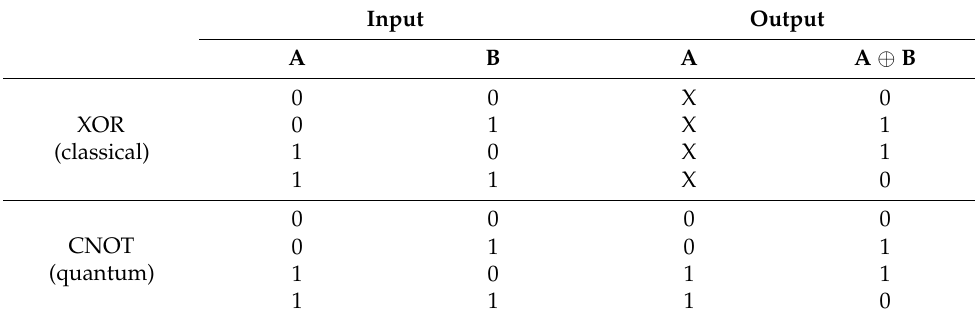
Figure 13. CNOT gate. Table 3. XOR Gate vs. CNOT Gate.